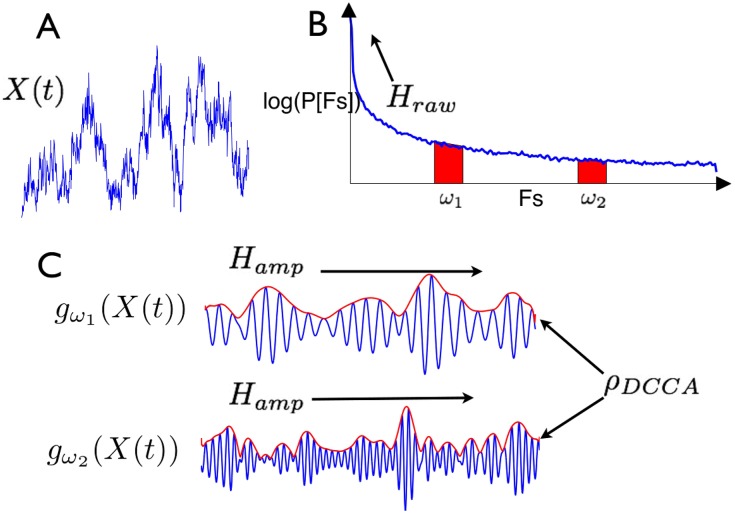
Overview of analysis steps.(A) The neural signal is extracted from the data. (B) Its power-spectum takes the form of a power-law. (C) Narrowband components in two frequency ranges (red on power-spectrum) are extracted from the signal by filtering and the amplitude envelope is extracted using the Hilbert transform (in red).